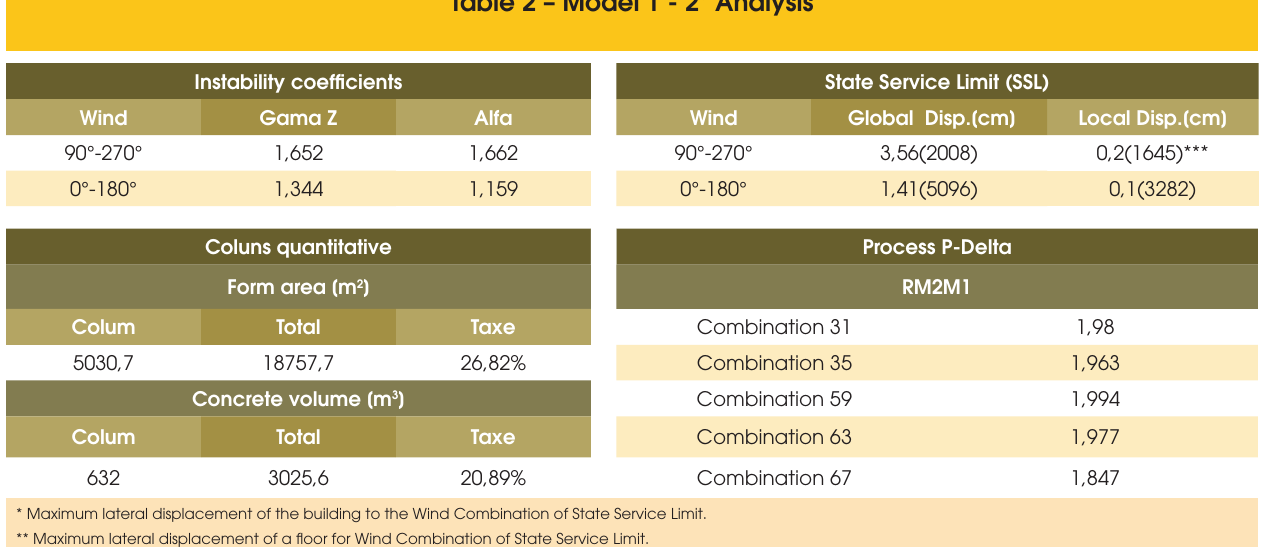
* Maximum lateral displacement of the building to the Wind Combination of State Service Limit.